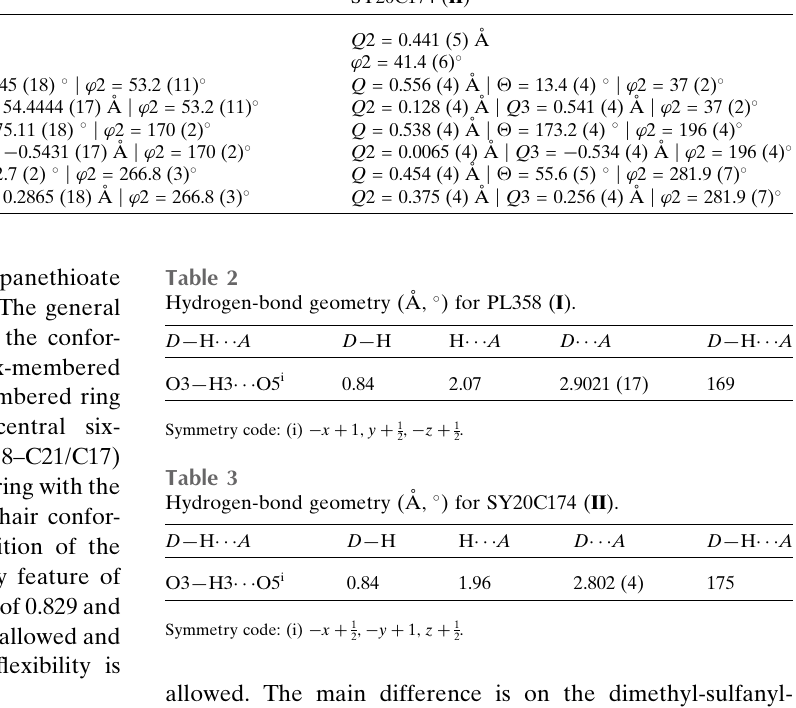
Table 1 Ring puckering parameters. Compound